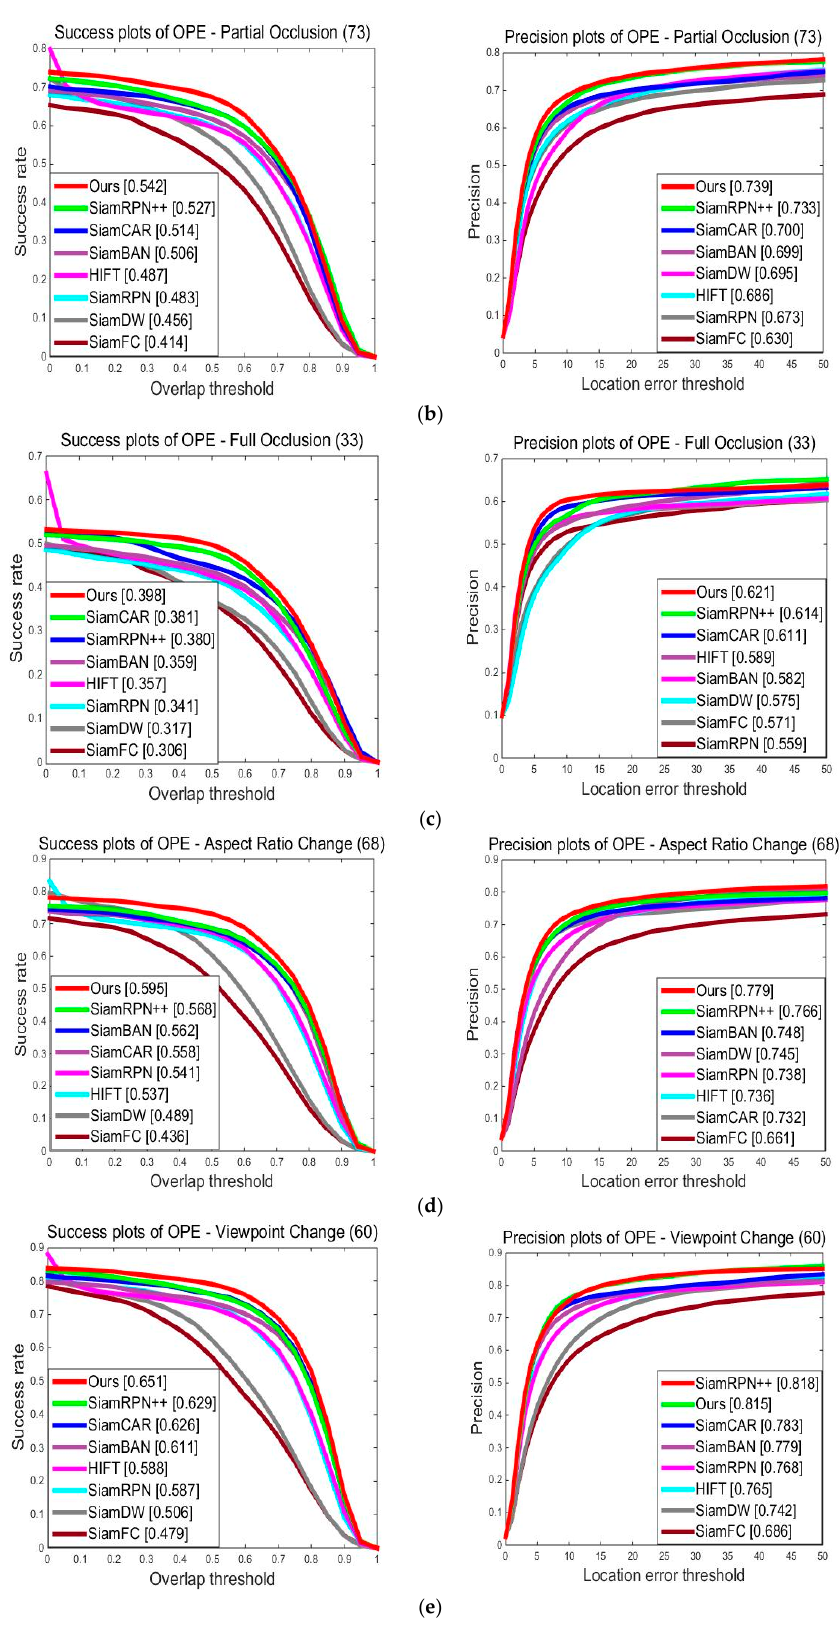
Figure 6. Experimental results corresponding to 5 typical scenarios, including ( a ) Similar Object; ( b ) Partial Occlusion; ( c ) Full Occlusion; ( d ) Aspect Ratio Change; ( e ) Viewpoint